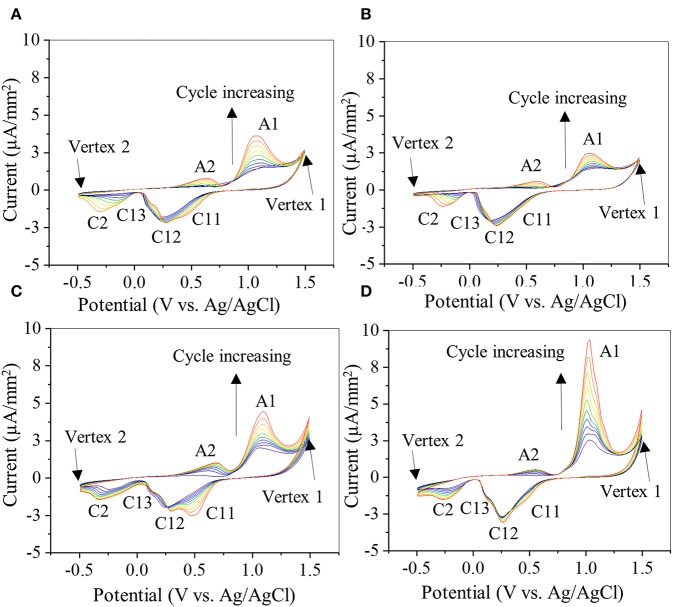
Cyclic voltammogram of gold electrode coated with 20-2S (A), 22S (B), 20-2NS (C), and 22NS (D) scanned at rate of 0.1 V/s for 10 cycles. Anodic peaks are denoted by A1 and A2 and cathode peaks are denoted by C11, C12, C13, and C2. Current level is normalized by the area of the gold electrode coated with PDA.